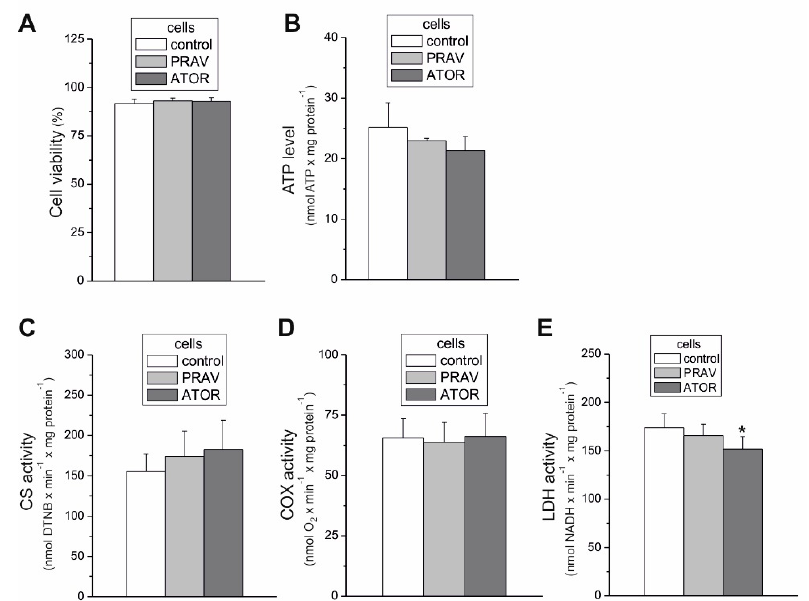
Figure 1. Cell viability ( A ), ATP level ( B ), maximal activities of marker enzymes of aerobic ( C, D ), and anaerobic catabolism ( E ) of endothelial EA.hy926, 100 nM atorvastatin (ATOR) ‐ treated and 100 nM pravastatin (PRAV) ‐ treated cells. Mean ± standard deviation (SD); n = 5; p < 0.05 (*), comparison vs. control values. Int. J. Mol. Sci. 2020 , 21 , 1485